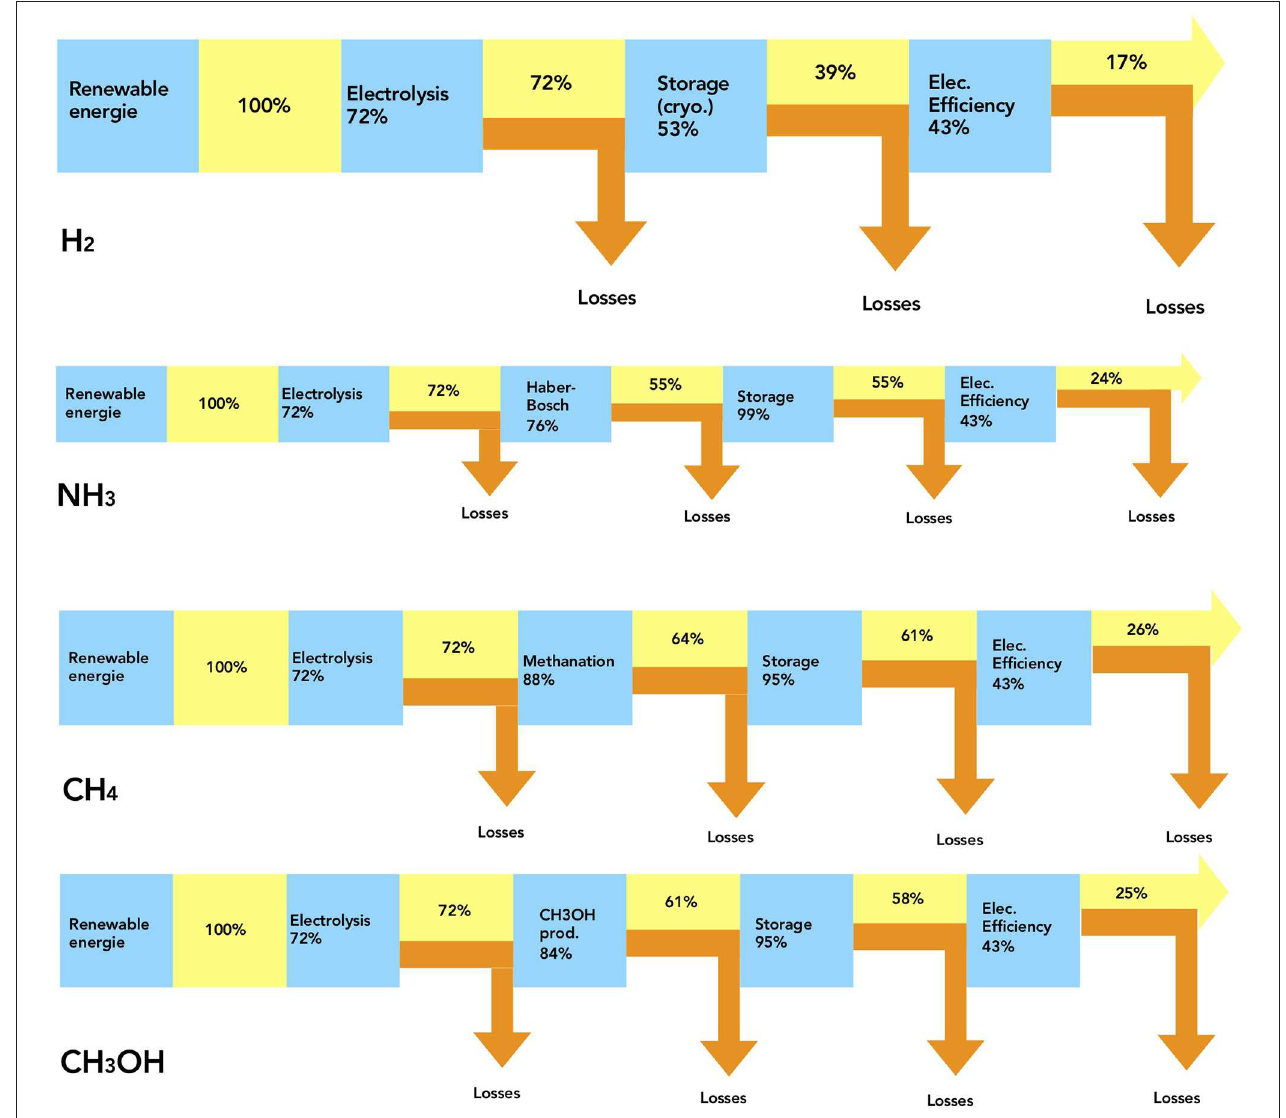
FIGURE 3 | Electric energy restitution, cumulative and step efficiency for H 2 , NH 3 , CH 4 , and CH 3 OH—based on Olson and Holbrook (2007), Bartels (2008), Connolly et al. (2014, 2015, 2016), and Matzen et al.